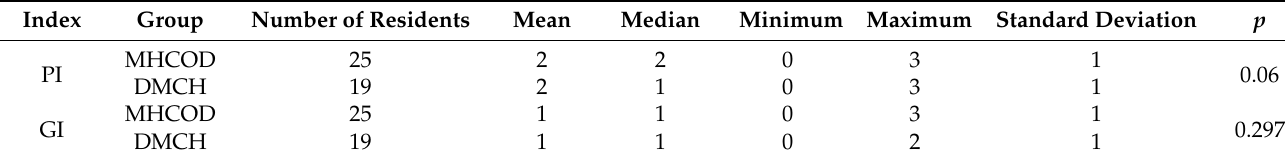
Table 4. PI and GI scores in the study groups.